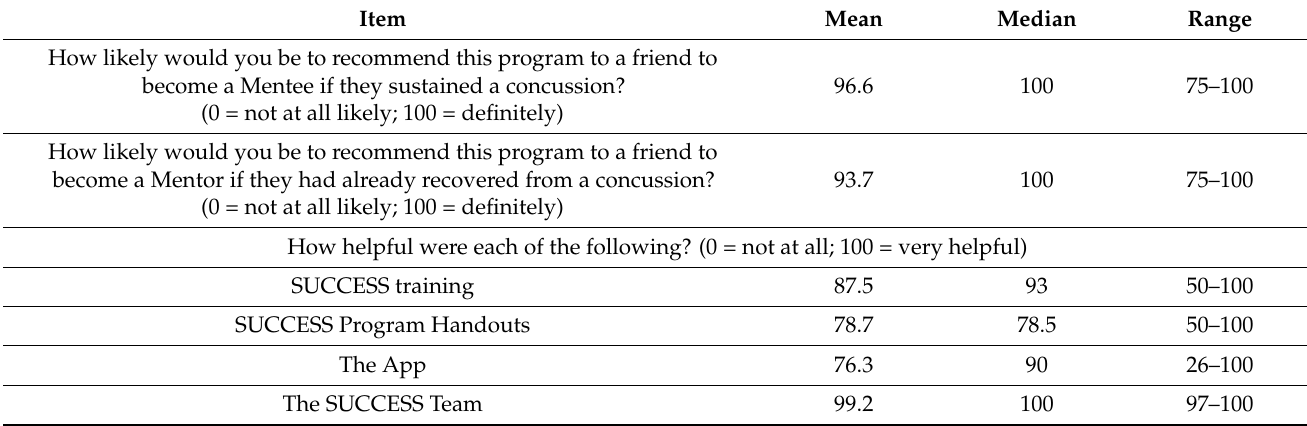
Table 4. SUCCESS Mentor Post-Mentoring Feedback